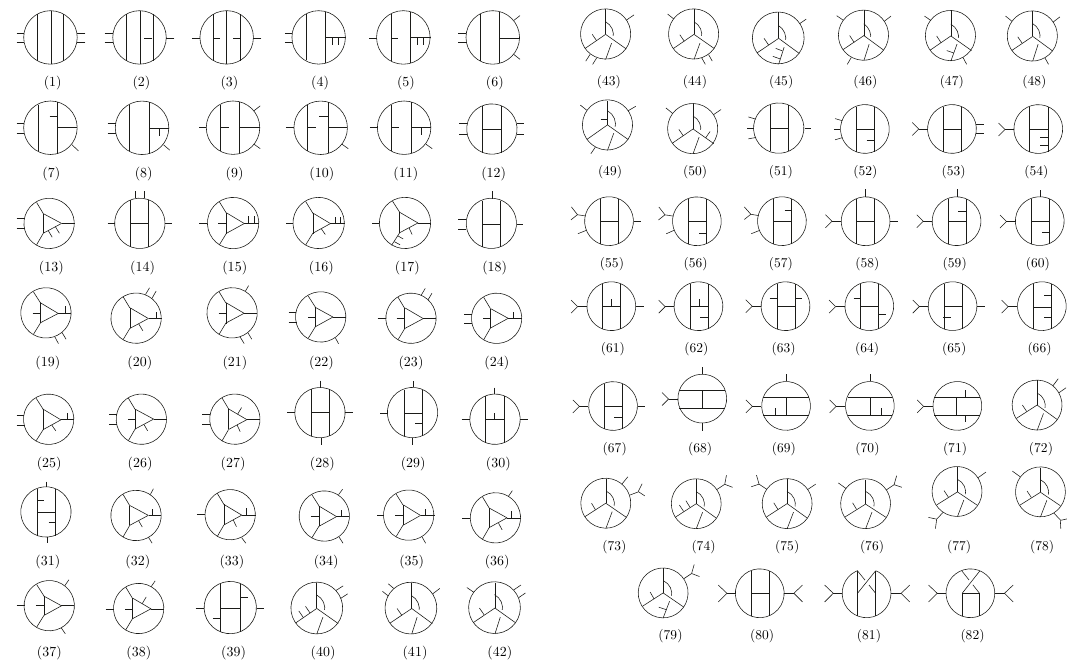
FIG. 7: Diagrams 43–82 for the four-loop four-point amplitudes of = 4 and = 5 supergravity. N N = 4 and = 5 super- N N = 4 super-Yang-Mills diagrams of Ref. [39]. Figure 1 . 82 diagrams in = 5, 4 loops. The individual diagrams are UV divergent in d=4, but N N (83) (84) (85) FIG. 8: The bubble-on-external-leg diagrams of = 4 super-Yang-Mills theory. These do not N contribute to = 4 and = 5 supergravity. N N